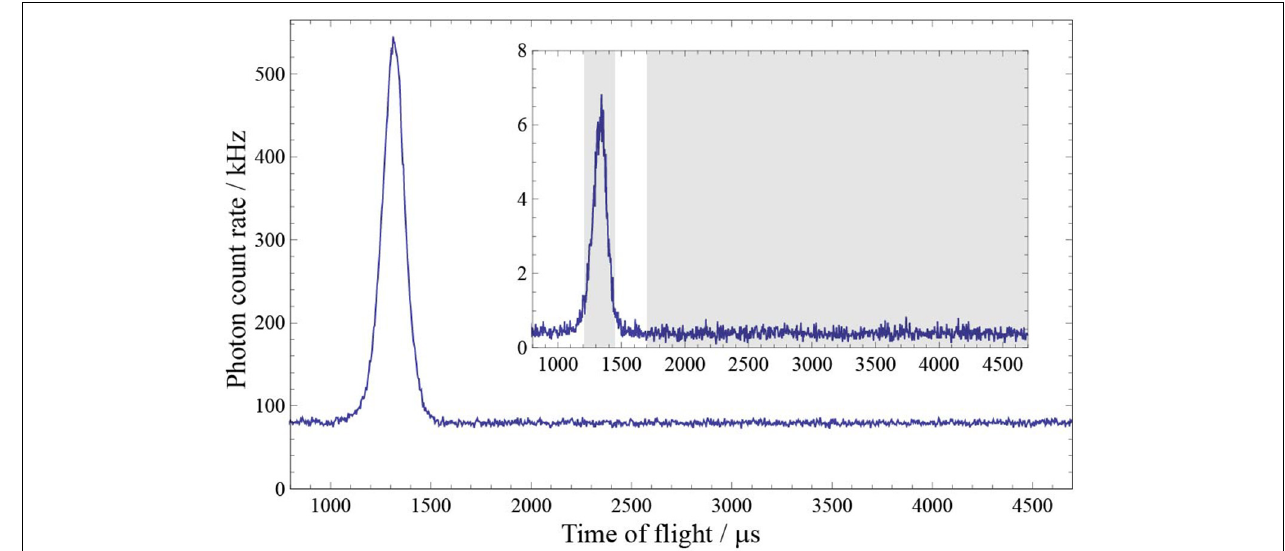
dissociation laser fires at t = 0. The shaded regions in the inset show the time windows used to determine the number of signal and background photons.